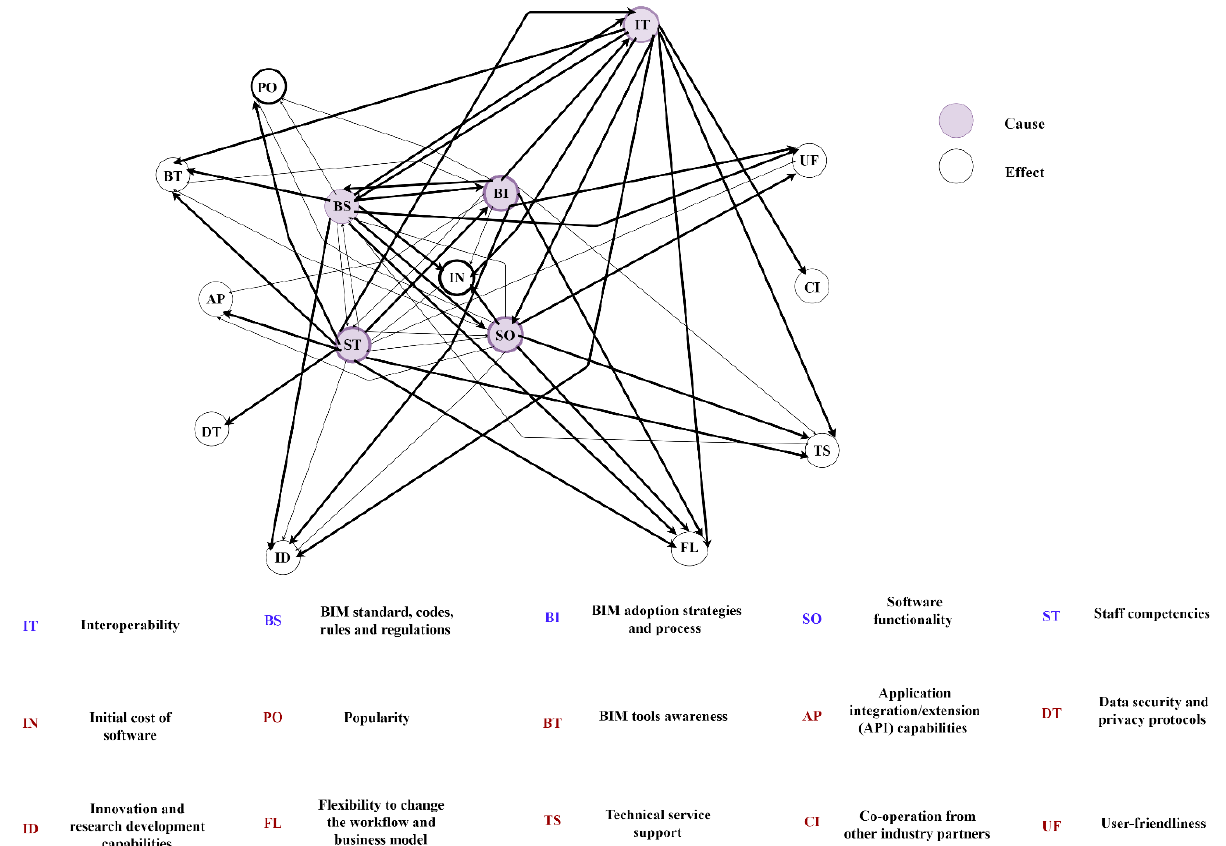
Figure 4. Strategy diagram for BIM software selection.